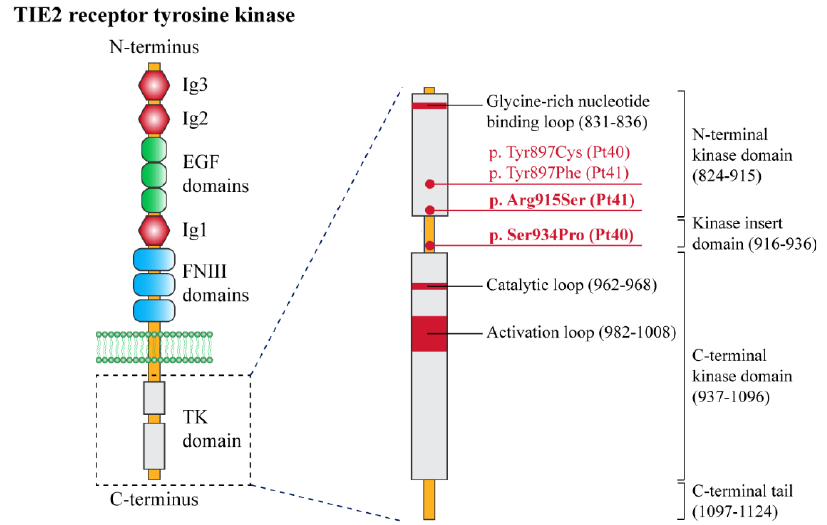
Figure 9. Structural organization of the receptor tyrosine kinase TIE-2 with the position of the pathogenic variants identified in this study. Left panel: schematic of the domain structure of the TIE-2 receptor. The extracellular portion of the receptor contains three epidermal growth factor (EGF)-like domains (green circles) flanked by three immunoglobulin (Ig)-like domains (Ig1, Ig2, and Ig3) (red hexagons), followed by three fibronectin type III (FNIII) domains. A single-pass transmembrane domain (phospholipidic bilayer is represented in green) precedes an interrupted tyrosine kinase (TK) domain (light grey) within the intracellular C-terminal tail. Right panel: detailed representation of the TK domain, with its functional sites, and the pathogenetic variants identified in this study (red dots). The new variants (p.Arg915Ser and p.Ser934Pro) are indicated in bold. TIE-2 domain amino acid numbers (bracketed) are based on literature data [14,17] and the UniProt